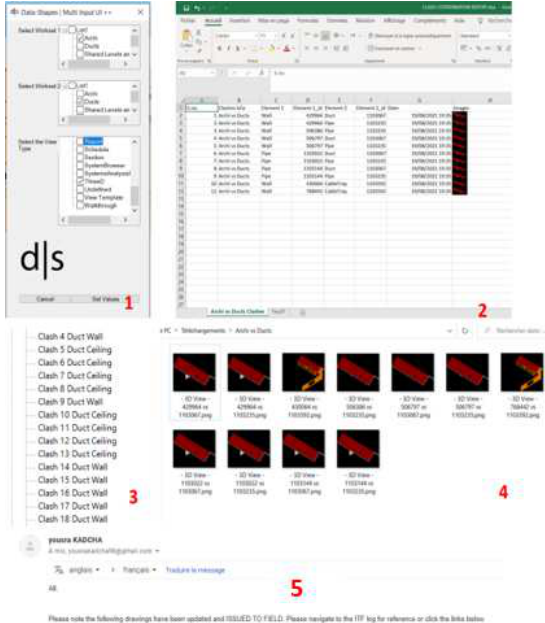
Figure 4. Extraction of the c ost SQLite database